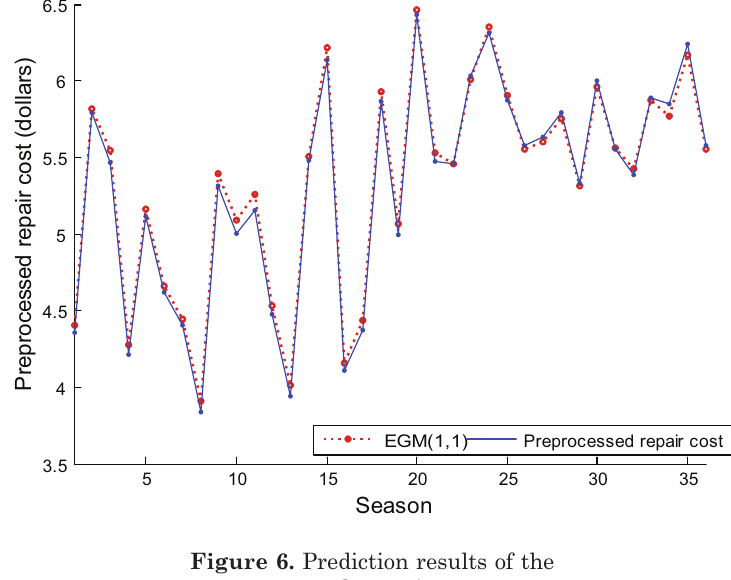
figure 6. Prediction results of the quarterly repair